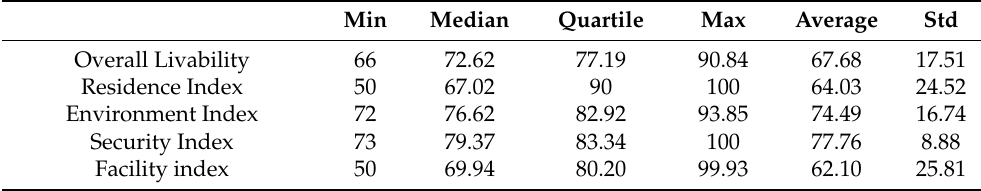
Table 3. Overall and dimension assessment scores of community